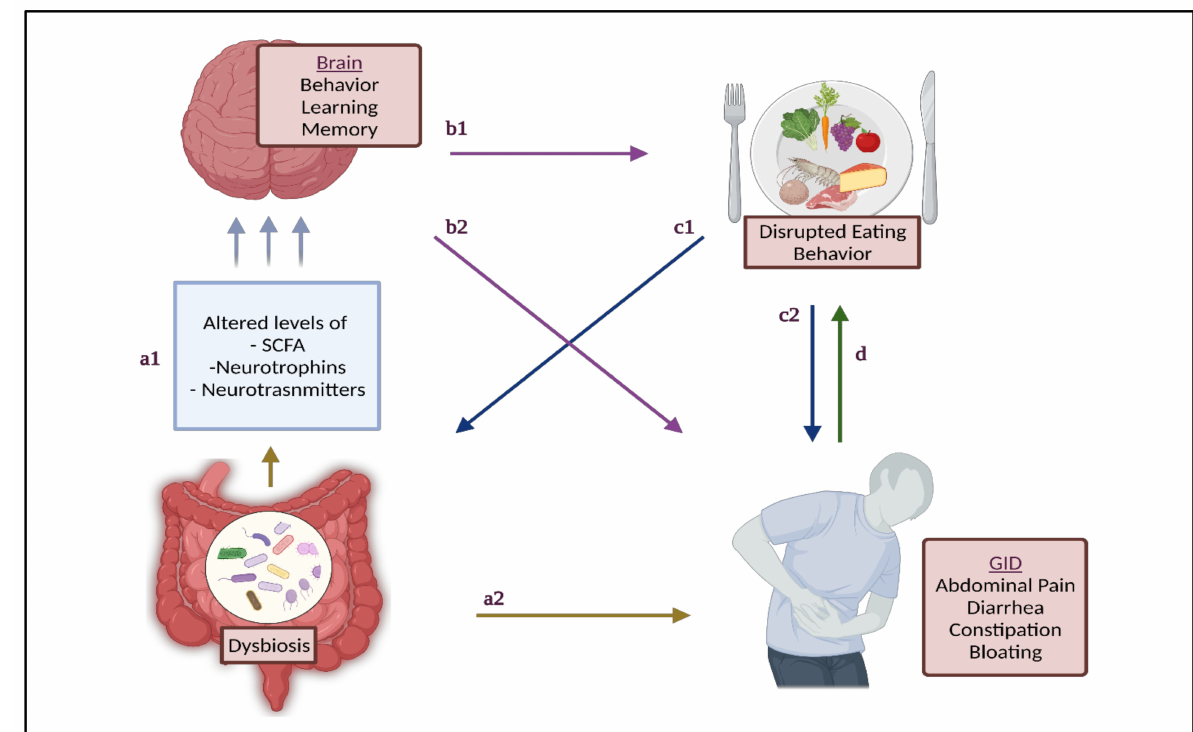
Figure 1. The brain–gut–microbiome axis in the etiology of gastrointestinal disorders in autism spectrum disorder: ( a1 ) Signaling molecules from GM communicate with various organs, including the brain affecting ASD-related behavior. ( a2 ) Dysbiosis contributes to GID. ( b1 ) ASD severity may increase risk of disrupted eating behavior, affecting the quantity and quality of food intake. ( b2 ) ASD severity manifests as a lack of ability to communicate GID presence, contributing to increased symptoms and severity. ( c1 ) Disrupted eating behavior compromises diet quality, contributing to altered GM composition. ( c2 ) Disrupted eating behavior contributes to GID directly and indirectly through ( a2 ). ( d ) GID presence and severity contributes to compromised eating, thereby disrupted eating behavior. ASD: autism spectrum disorder; GID: gastrointestinal disorders; GM: gut microbiome; SCFA: short-chain fatty